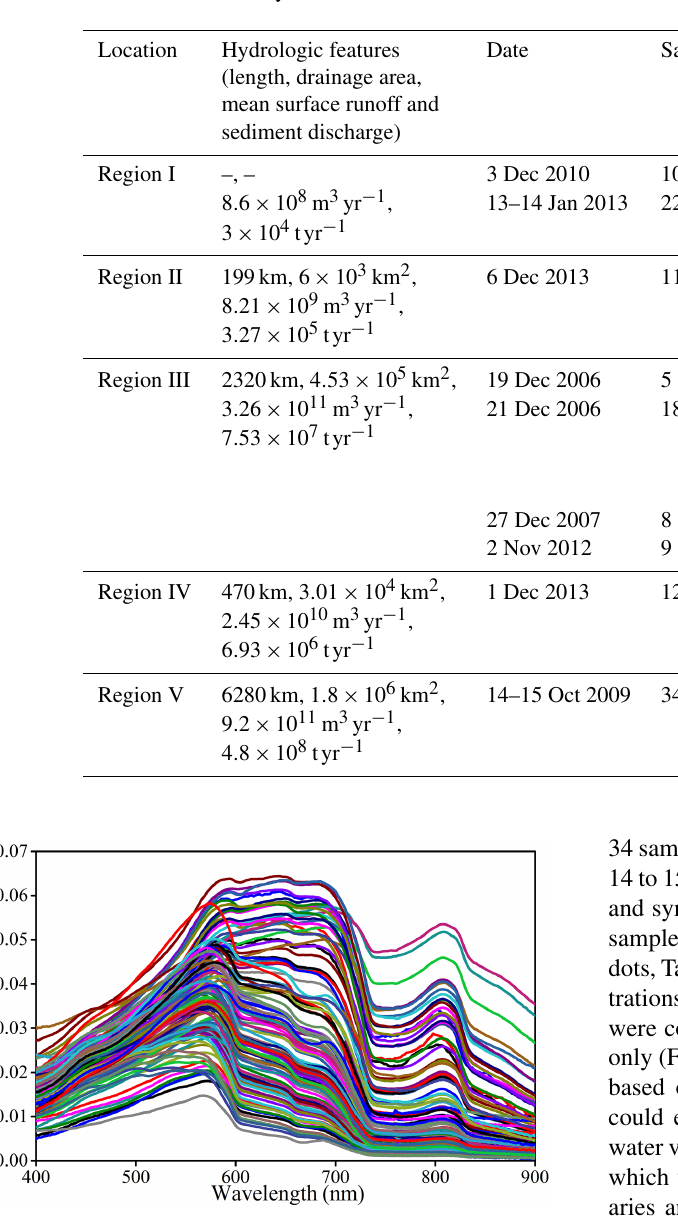
Figure 2. A total of 119 spectra were collected from study areas by